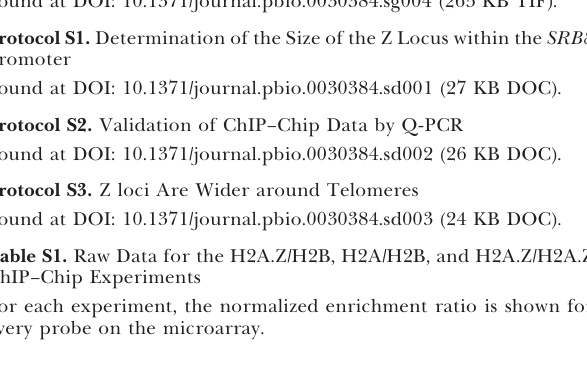
Protocol S1. Determination of the Size of the Z Locus within the SRB8 Promoter Protocol S2. Validation of ChIP–Chip Data by Q-PCR Found at DOI: 10.1371/journal.pbio.0030384.sd002 (26 KB DOC). Protocol S3. Z loci Are Wider around Telomeres Found at DOI: 10.1371/journal.pbio.0030384.sd003 (24 KB DOC). Table S1. Raw Data for the H2A.Z/H2B, H2A/H2B, and H2A.Z/H2A.Z ChIP–Chip Experiments For each experiment, the normalized enrichment ratio is shown for every probe on the